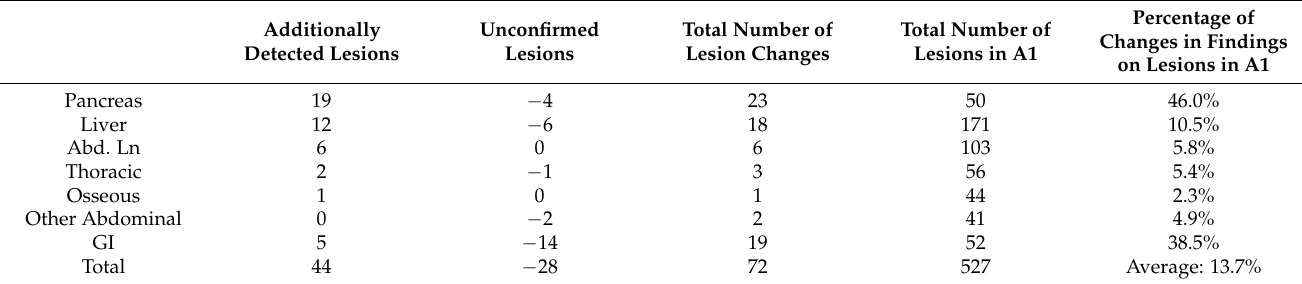
Table 2. Differences in 68 Ga-DOTATOC-PET/CT-positive lesions in NET